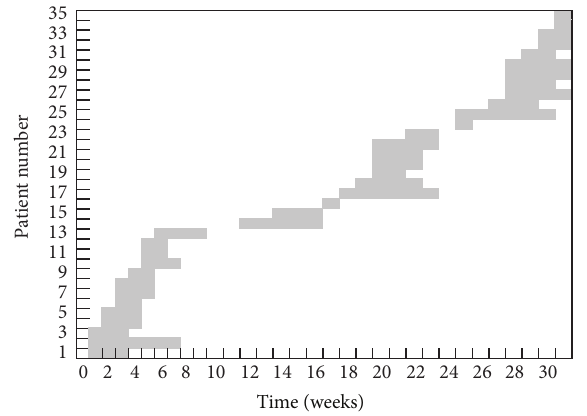
Figure 3: Timeline for ICU stay for patients infected/colonized with ACB complex, December, 2011, to June,